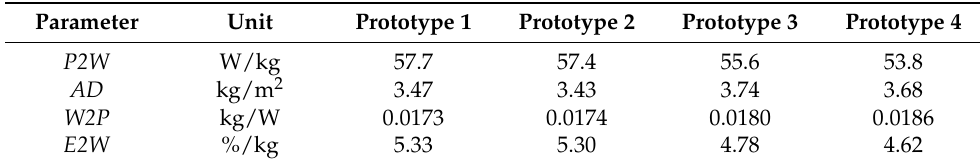
Table 5. Lightweight modules indicators calculated for each prototype.